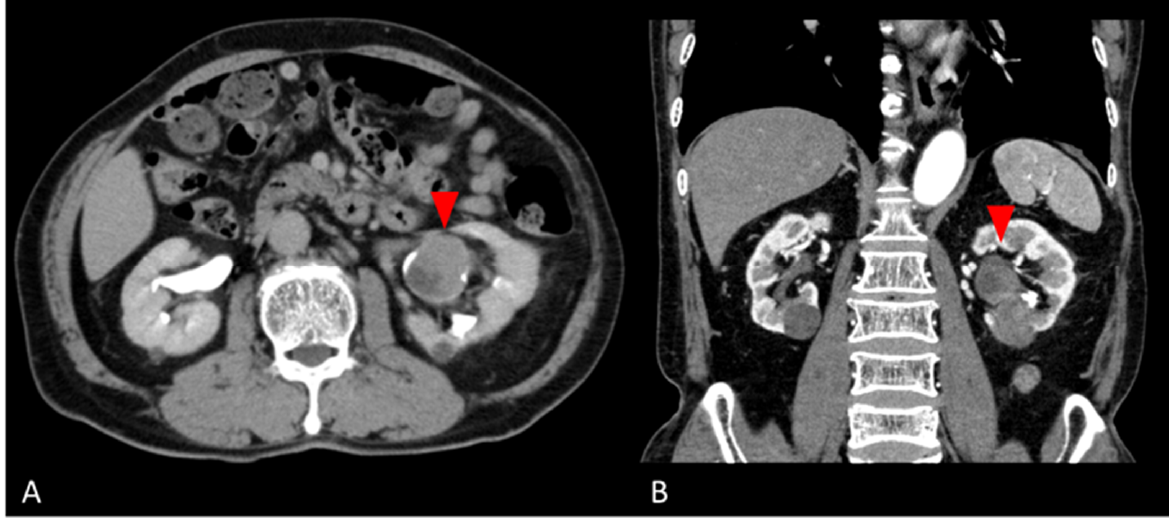
Figure 1. Preoperative abdominal CT images. ( A ) Axial and ( B ) coronal contrast-enhanced CT images show a hypovascular mass in the lower pole of the left kidney (red arrows).